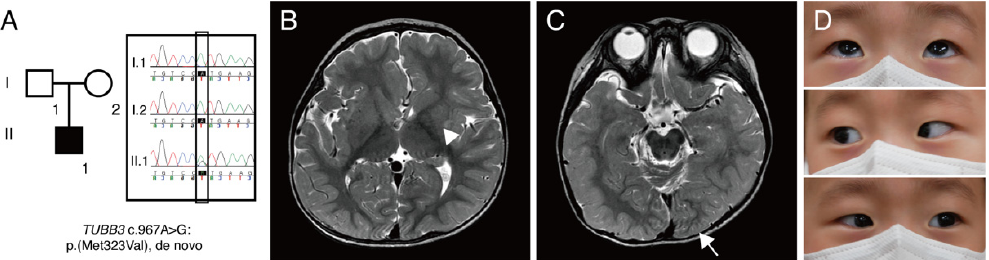
Figure 1. ( A ) A pedigree of patient reported in this study. Square, male; round, female; black coloring, affected individual. Targeted next-generation sequencing showed TUBB3 c.967A>G:p.(M323V) variant. Sanger sequencing confirmed that this variant is a de novo mutation. ( B ) Brain magnetic resonance imaging showing cortical dysplasia. T2-weighted images without contrast revealed an asymmetric caudate nucleus (arrowhead) and globular shape of both basal ganglia and thalamus. ( C ) Axial T2-weighted image showing an asymmetric configuration of an occipital lobe (arrow) and abnormal cerebellar vermian foldings. ( D ) Pictures of an extraocular motility examination showing a full range of motion.